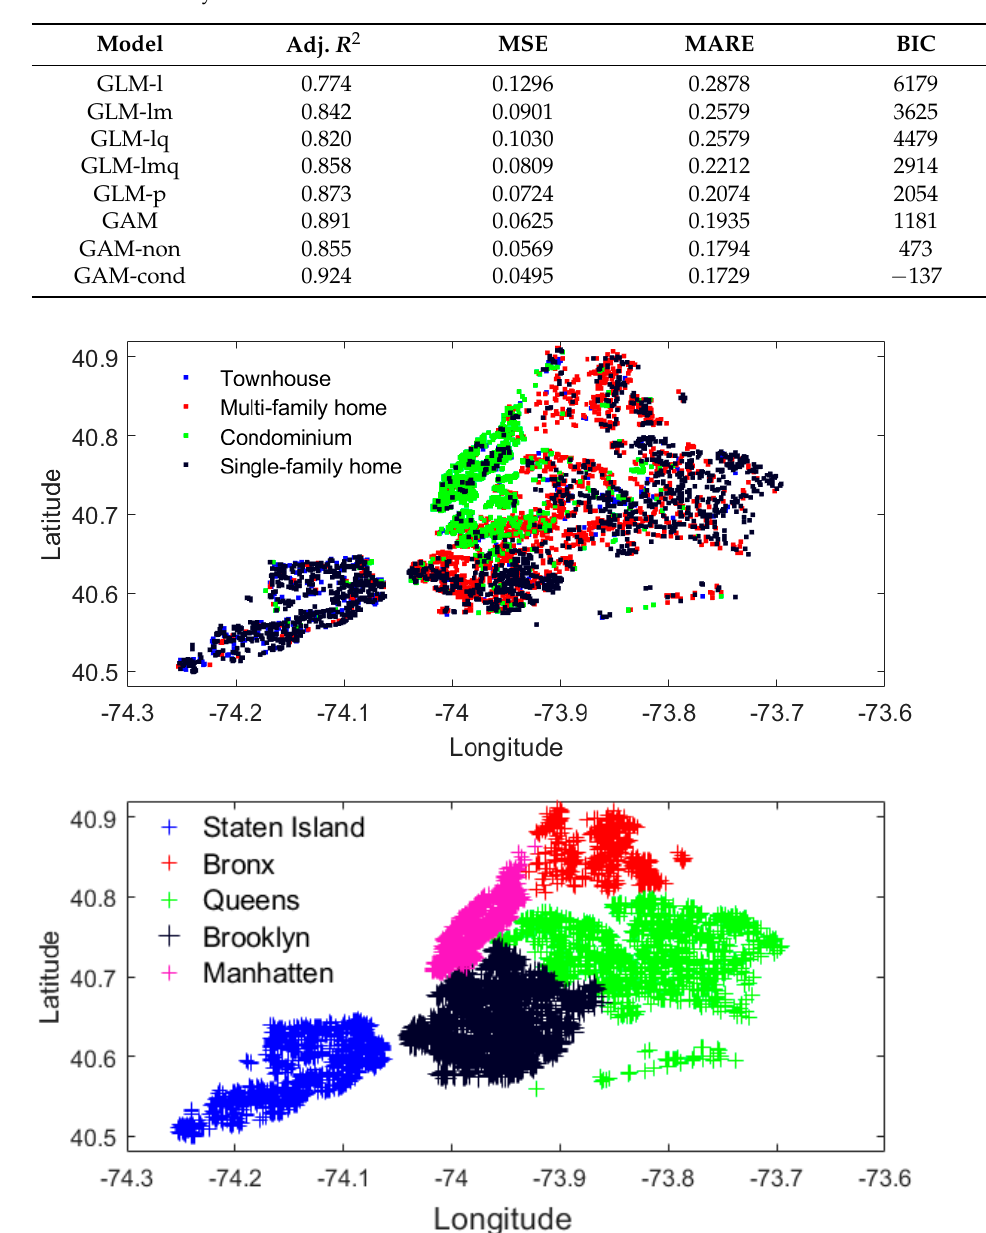
Figure 2. The spatial distribution of dwellings in NYC: ( top ) by type, ( bottom ) by borough.